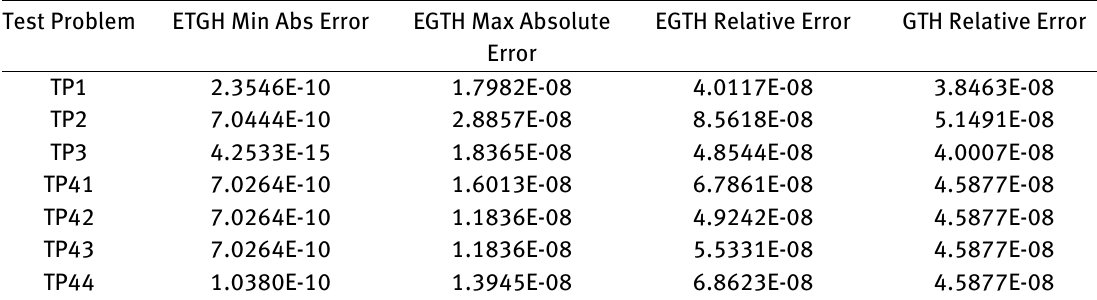
Table 6: Differences between single and double precision computations of the stationary